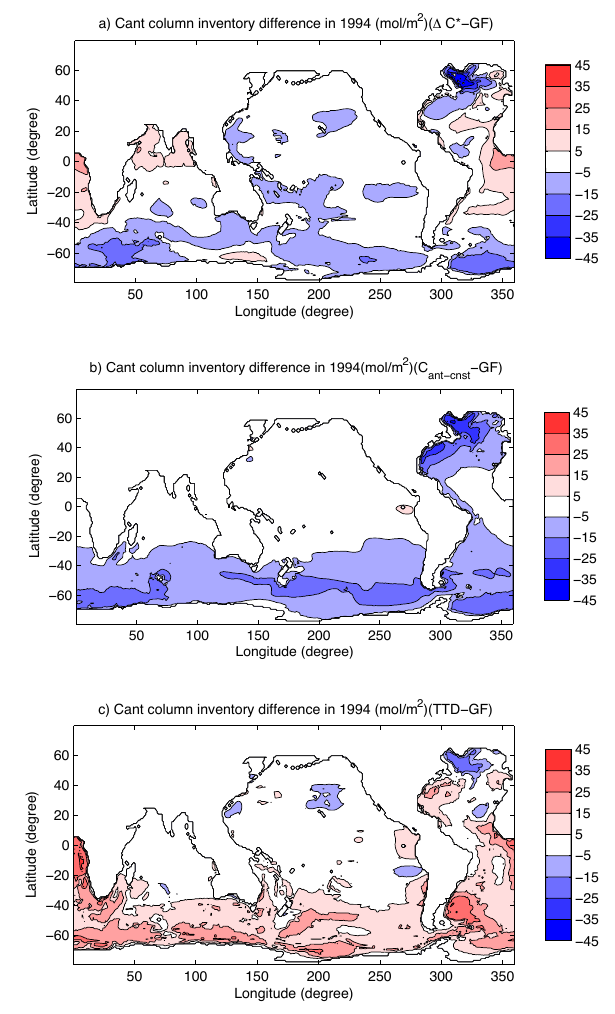
Fig. 2. Differences in column inventories between (a) the 1 C* method and the GF method; (b) the CCSM (C ant cnst ) and the GF method; (c) the TTD method and the GF method.